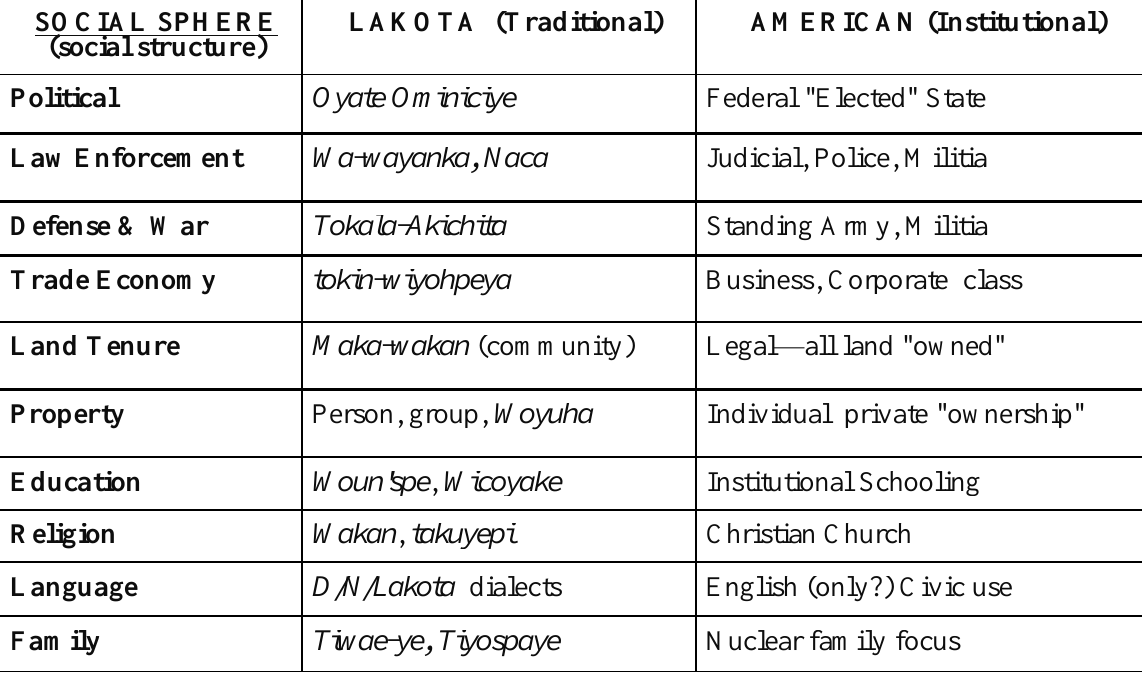
Table 1: Lakota – Euro-American Comparative Social Structures with U.S. Policies SOCIAL